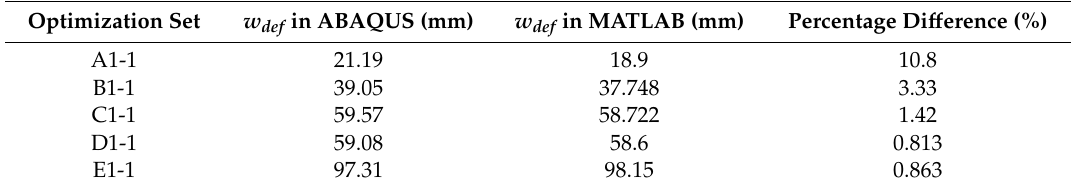
Table 7. Comparison of w def obtained from ABAQUS’s model based on the optimal design parameters for the search space given by ϕ 1 = 45 ◦ , ϕ 2 = 0 ◦ . Optimization Set w def in ABAQUS (mm)